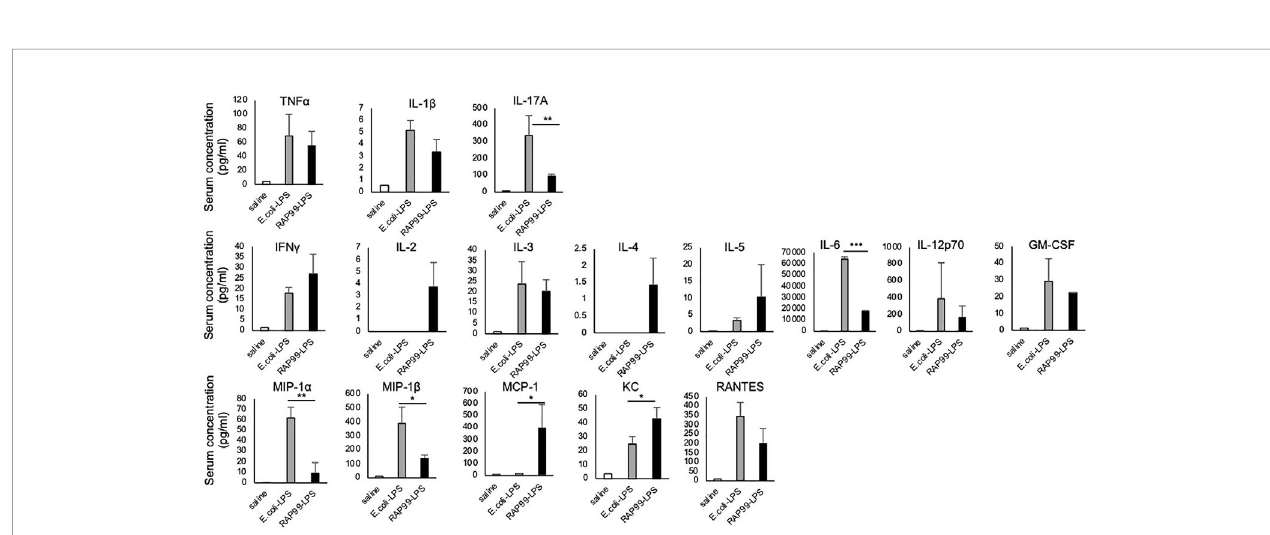
FIGURE 4 | RAP99-LPS induced immune cell activation. E. coli -LPS (200 m g/day), RAP99-LPS (200 m g/day), or saline was intraperitoneally injected into C57BL/6 mice followed by an analysis of IL-6 serum levels and serum cytokines and chemokines (pg/ml). Mean scores ± SD are shown. *p < 0.05, **p < 0.01, ***p < 0.001; Student ’ s t tests. Saline (n = 4), E. coli -LPS (n = 5), RAP-LPS (n = 5). (Representative data are